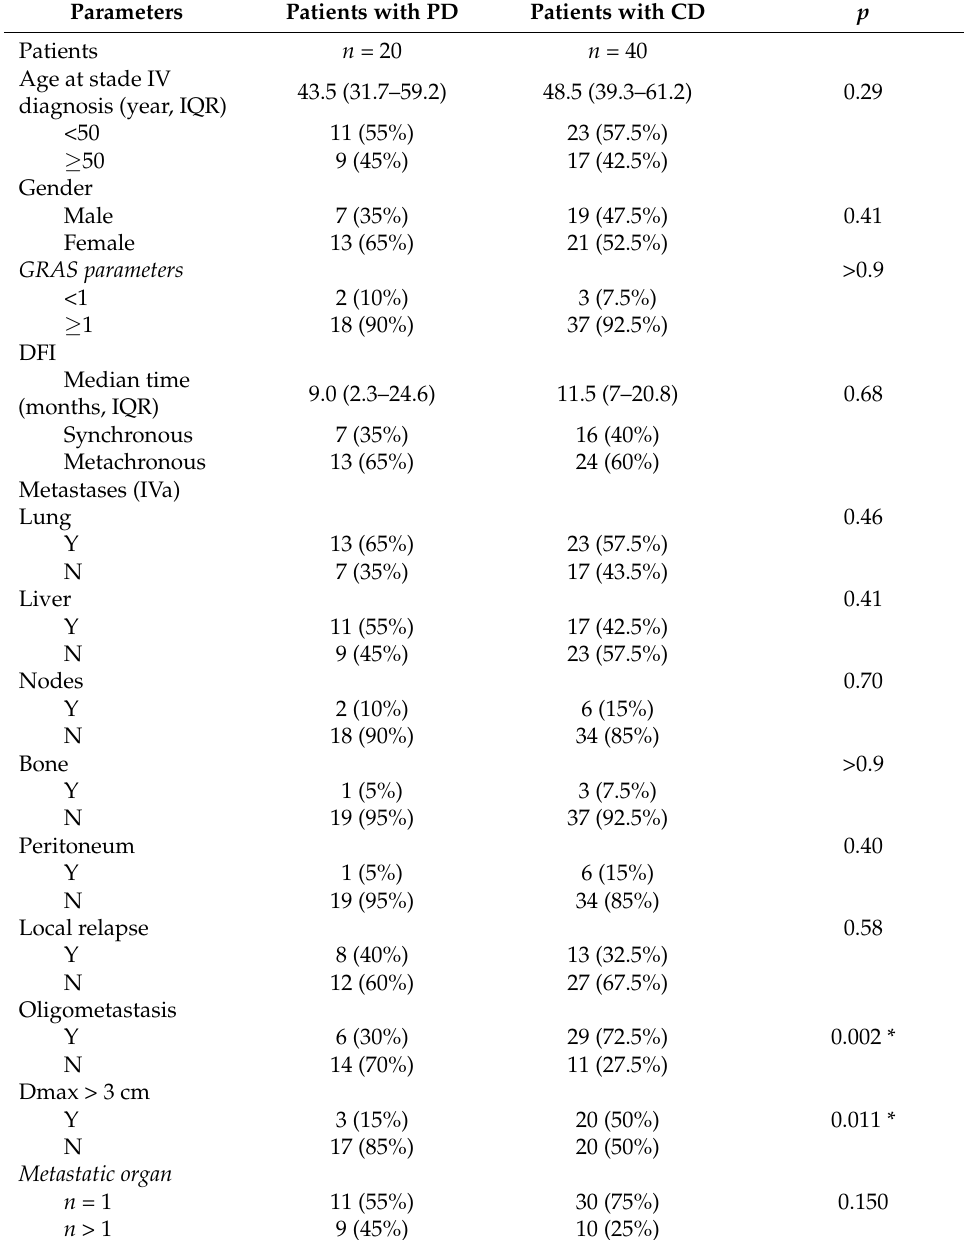
Table 3. Characteristics of patients with disease control (best response during follow-up).